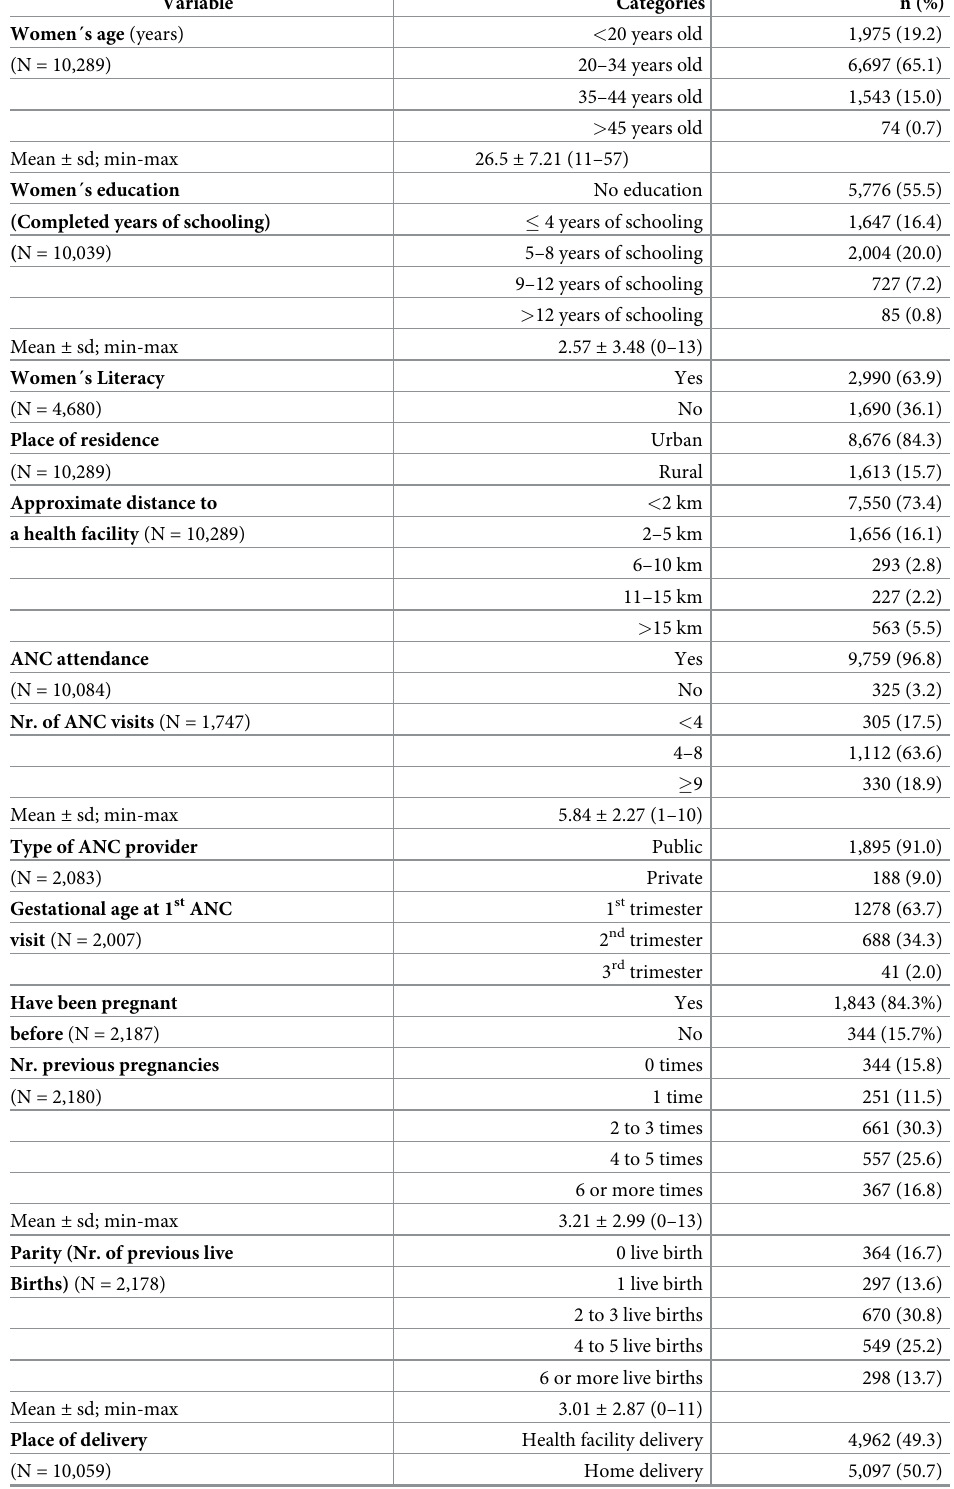
Table 1. Descriptive statistics of the